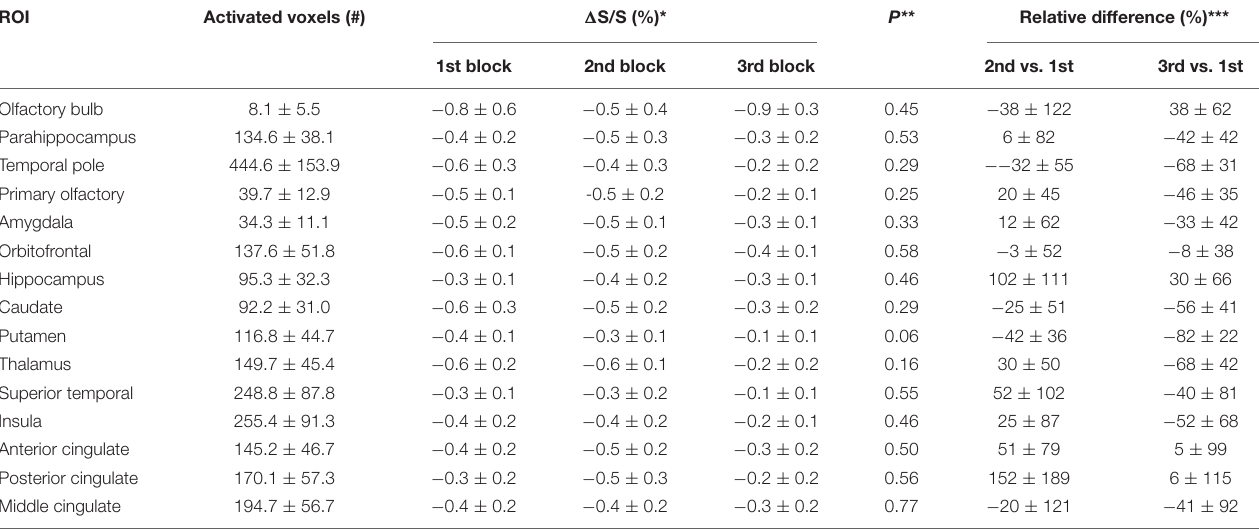
TABLE 3 | Quantitative T2prep BOLD fMRI results from negatively activated voxels from all subjects ( n = 14). ROI Activated voxels (#) (cid:49) S/S (%)* P** Relative difference (%)*** 1st block 2nd block 3rd block 2nd vs. 1st 3rd vs. 1st